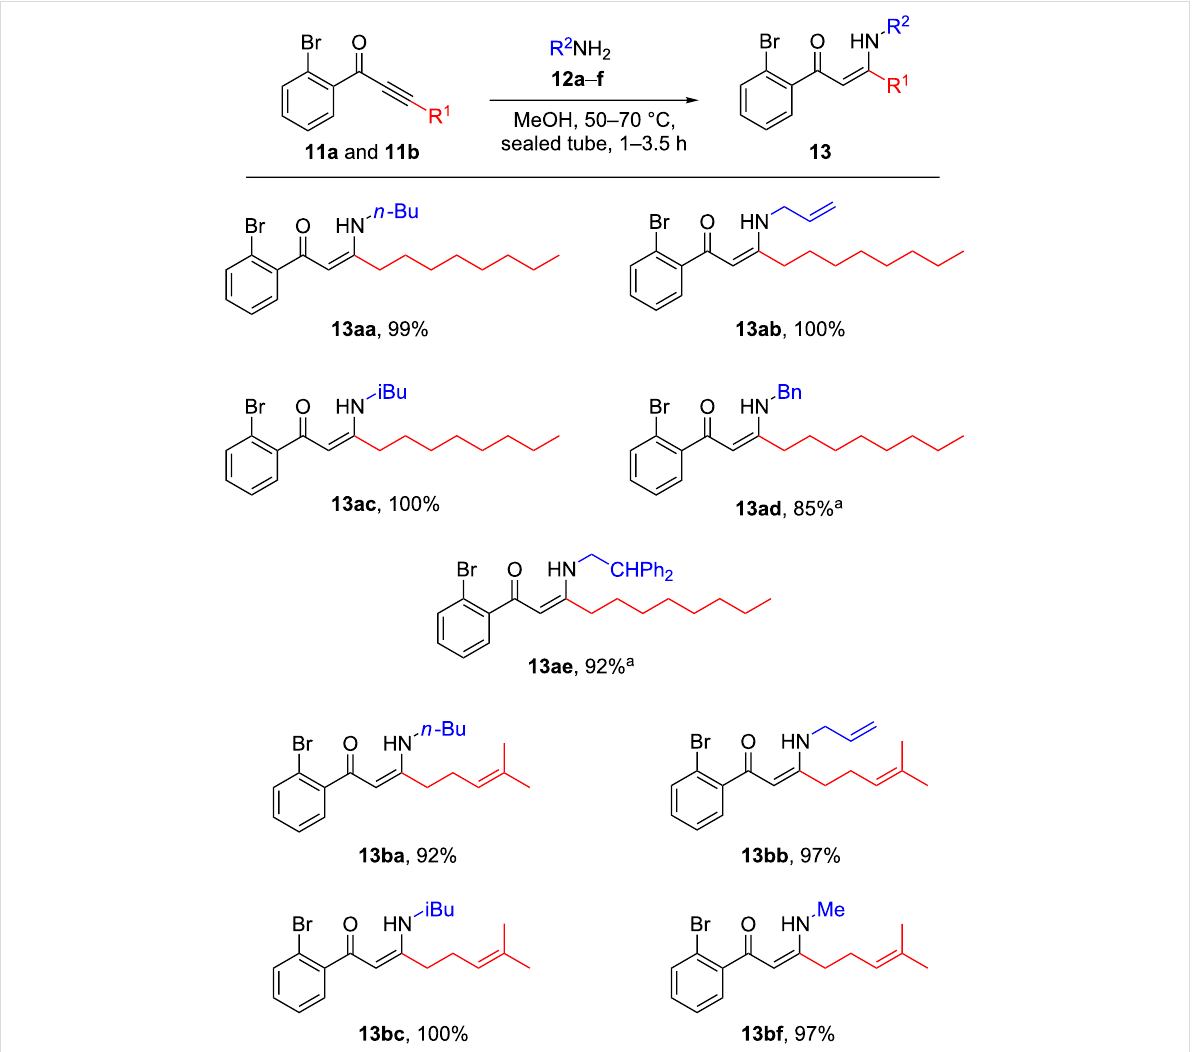
Scheme 3: Conjugate addition of primary amines 12a – f with ynones 11a and 11b . a Following concentration in vacuo, further purification using silica gel flash chromatography was